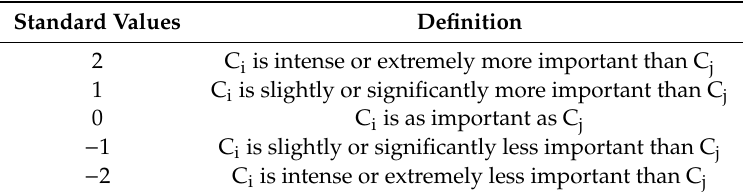
Table 2. Value-determined standard of the importance of index